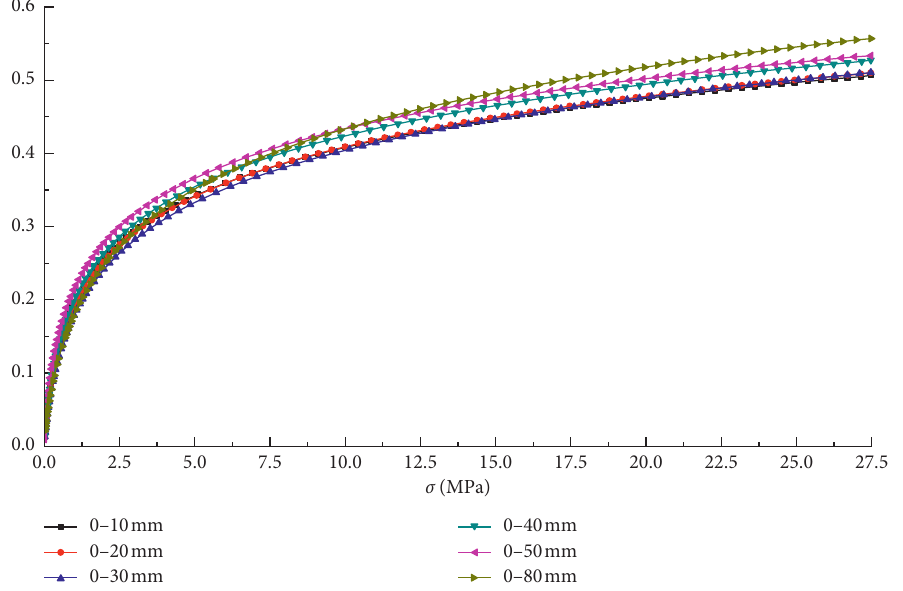
Figure 6: Stress-strain curves of coal gangue with different sizes.